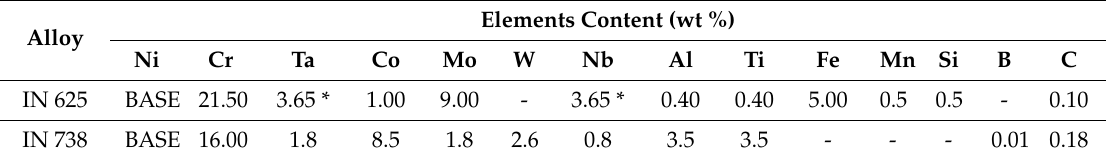
Table 1. Nominal chemical composition of Ni-base alloys used as a substrates.